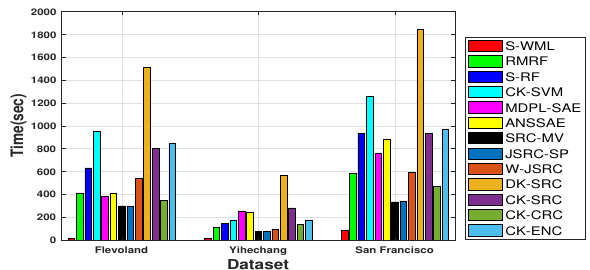
Figure 15. Execution time (in seconds) in the three PolSAR